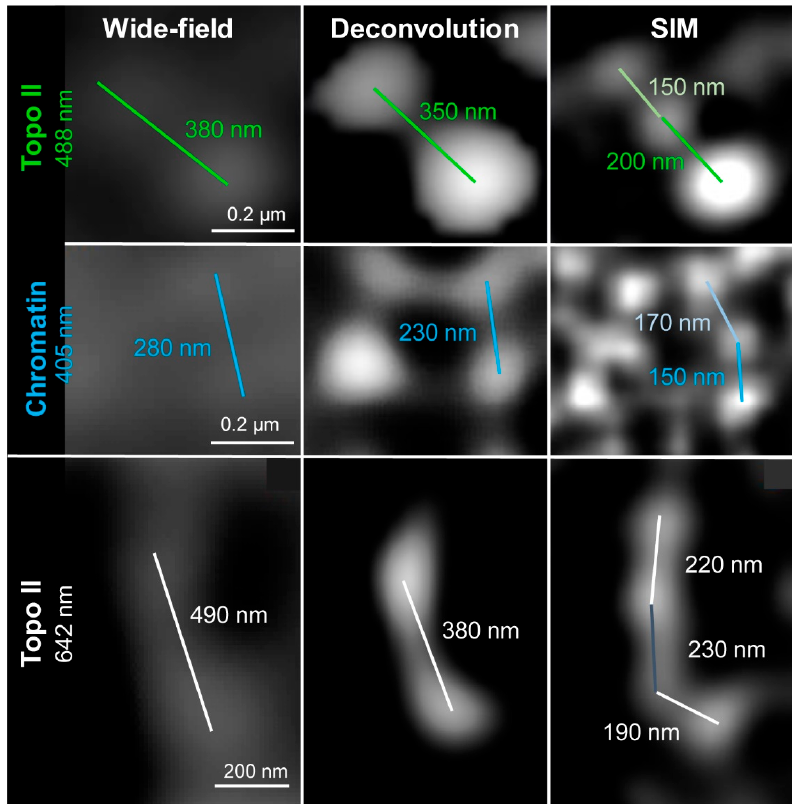
Figure 5. Measurements of the maximal achieved resolution of wide-field, deconvolved wide-field, and SIM by applying different fluorochromes. All images were acquired using the Elyra PS.1 microscope system. The achieved resolution was measured as the distance between the centers of two recognizable spots. Excitation laser lines were 488 nm for Topo II ( upper panel), 405 nm for chromatin ( middle panel), and 642 nm for Topo II ( lower panel). SIM revealed that bigger spots detected in wide-field and deconvolution consist of subclusters.